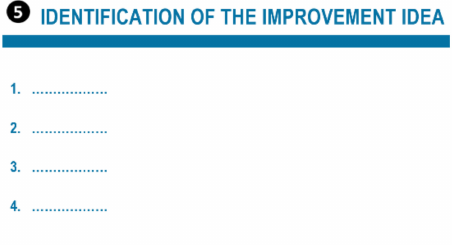
Figure 8. Improvement ideas.